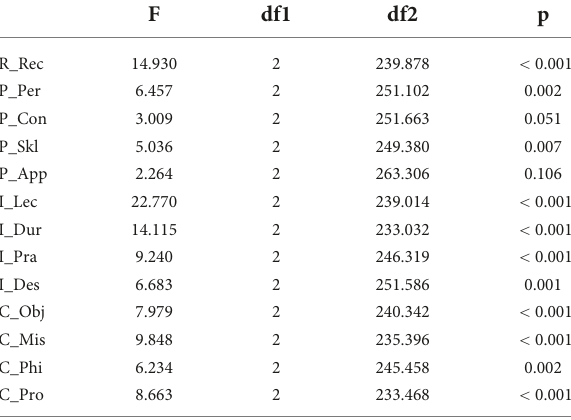
TABLE 5 Group descriptive by training method. TABLE 6 One-way